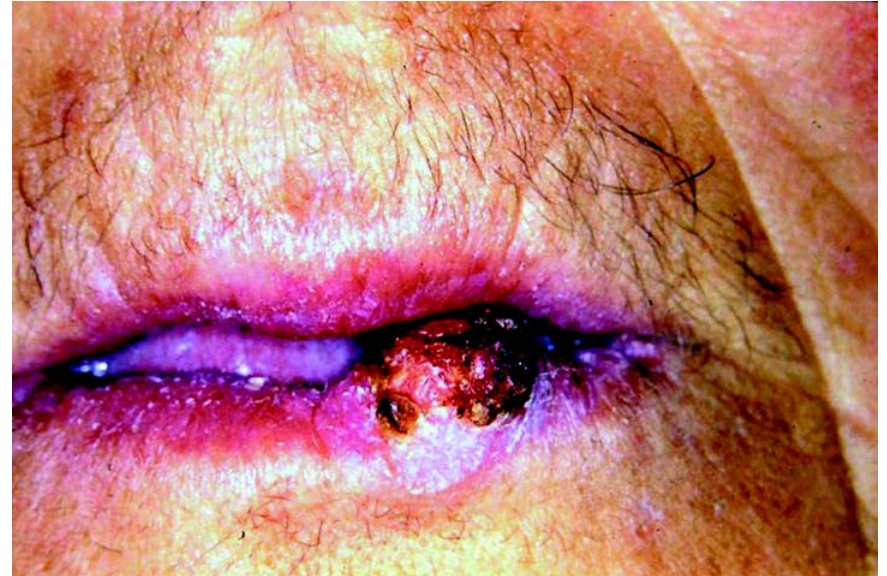
FIGURE 1- Initial aspect of the patient, showing a nodular exophytic lesion in the inferior lip, with superficial ulceration and partial brown-pigmented crust covering